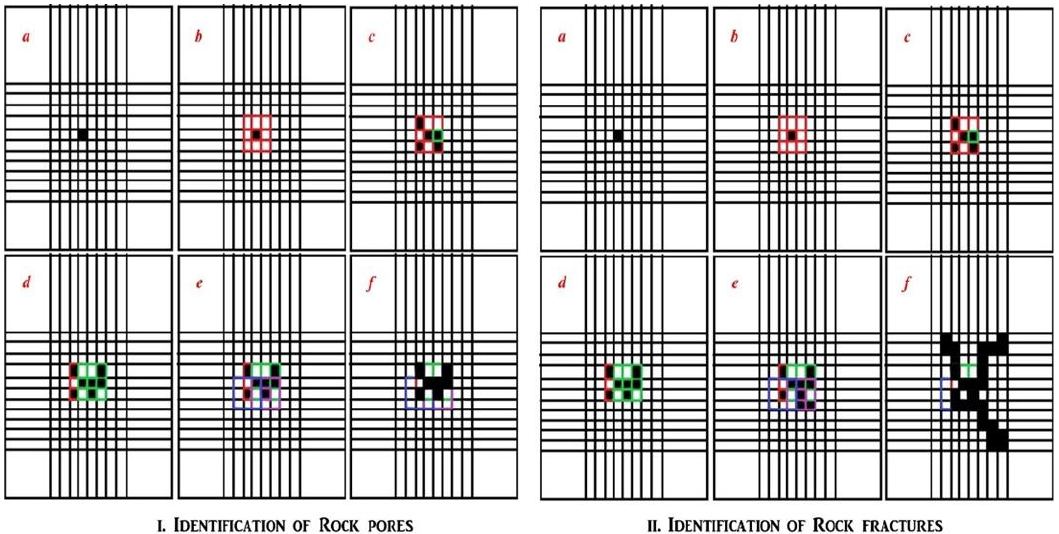
Figure 3. Conceptual diagrams of step-by-step from a to f each for identification of rock pores ( I ) and fractures ( II ) using the proposed k -IN approach. I a. ( for simplicity) identifies one dark pixel; I b. identifies its immediate neighbors (marked red); I c. finds the immediate dark pixels in the red marked cells (in I b. ) and points to one pixel whose nearest dark neighbors are to be found; finally, I f. i dentifies a pore by the recursive implementation of the step b. Quite similarly, we can detect a rock fracture in the current work. A rock fracture can also be seen as a series of connected pores in part ( II ).